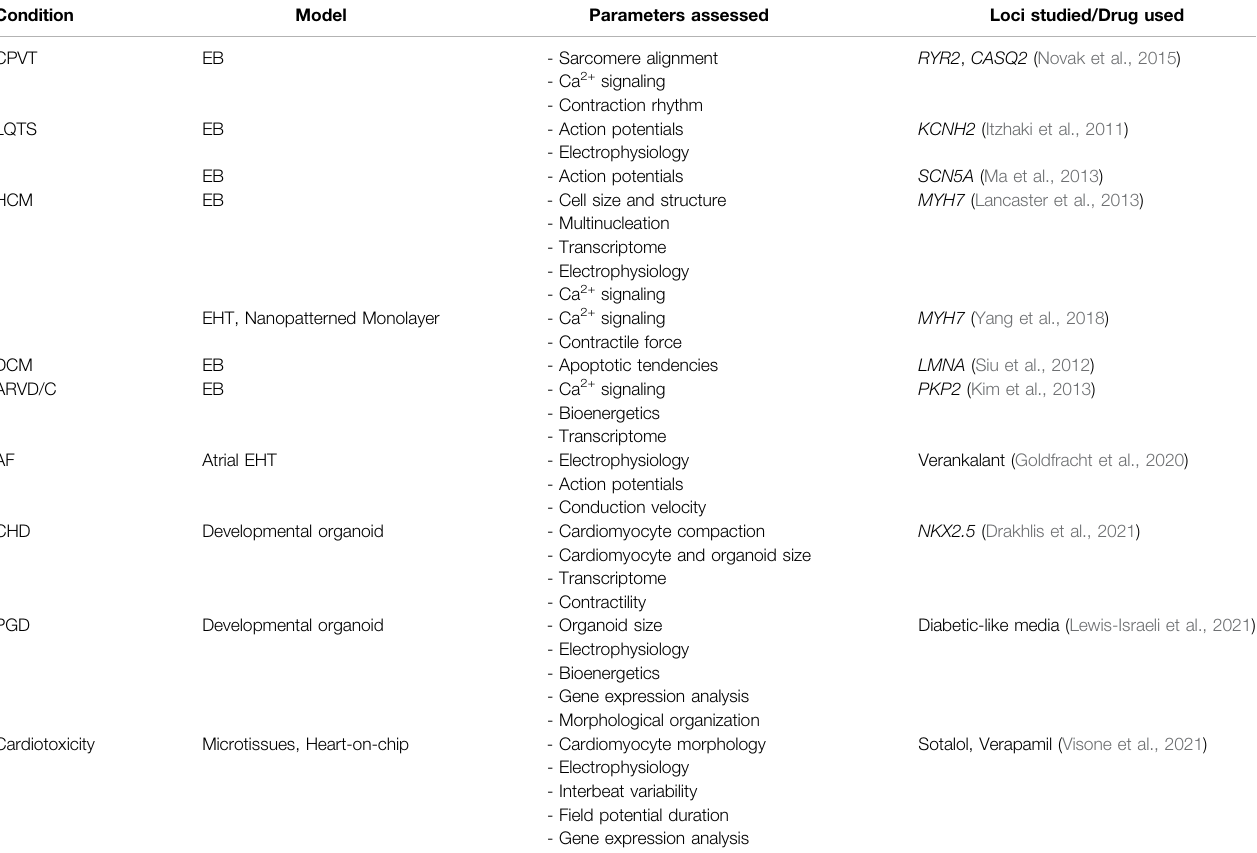
TABLE 1 | List of heart conditions modelled using various 3D cardiac models.